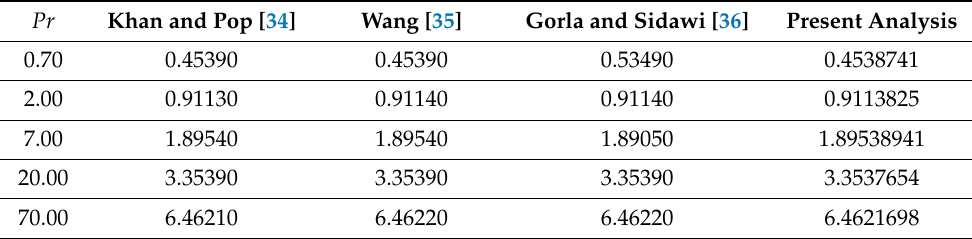
Table 4. The comparison results of Khan and Pop [34], Wang [35], and Gorla and Sidawi [36] with present analysis when the rest of the physical parameters were considered